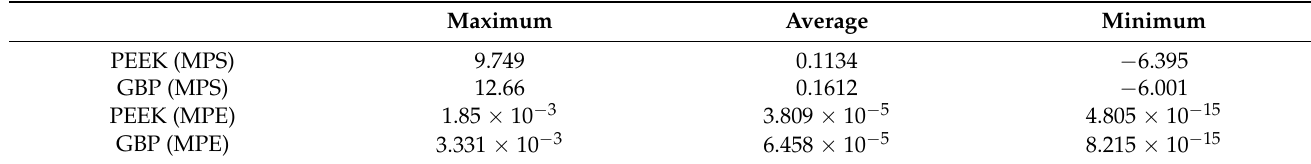
Table 4. Maximum principal stress values (in MPa) and maximum principal strain values (in mm/mm) of the PEEK and GBP clasps.